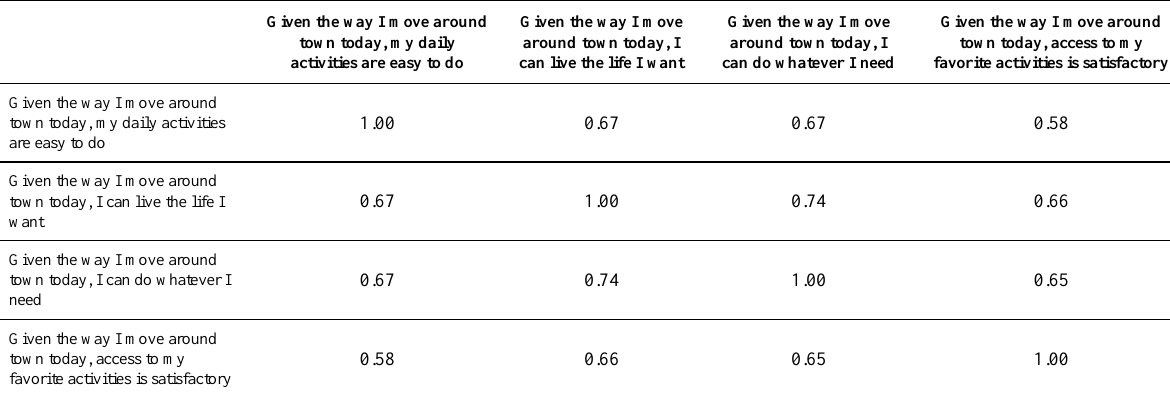
Figure 5. Priority transport modes to move around the city. Table 2. Pearson's matrix of pair correlation